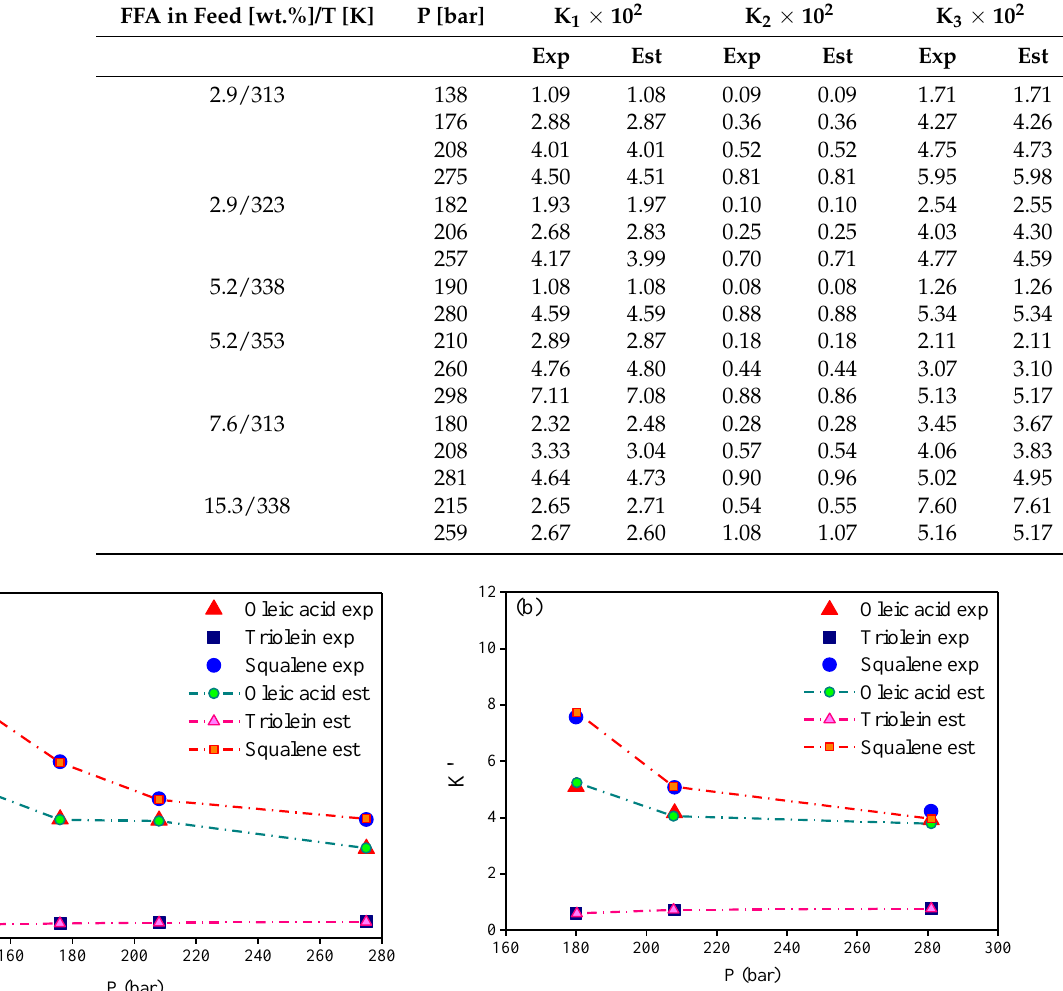
Table 17. The distribution coefficients-Ki of key compounds FFA (l), triglyceride (2), and squalene (3), expressed on a solvent free basis, by the experimental high-pressure phase equilibria for the multi- component system olive oil-CO 2 .